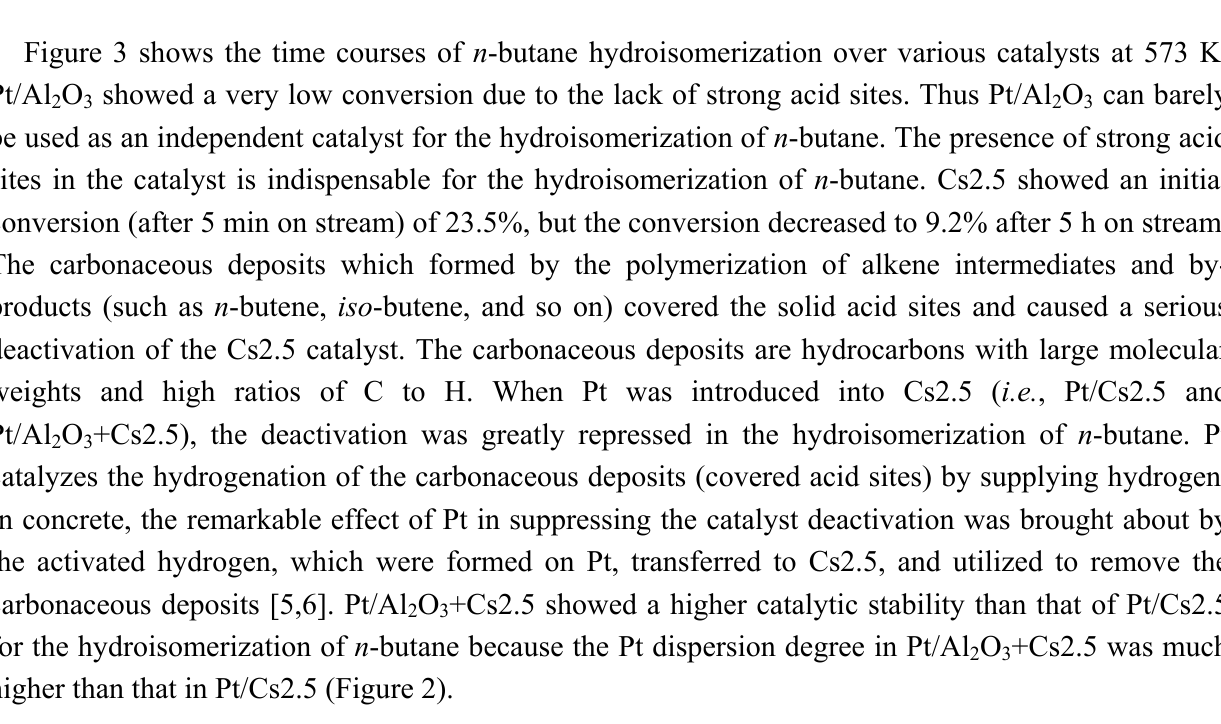
Figure 3. Time courses of the hydroisomerization of n -butane over various catalysts at 573